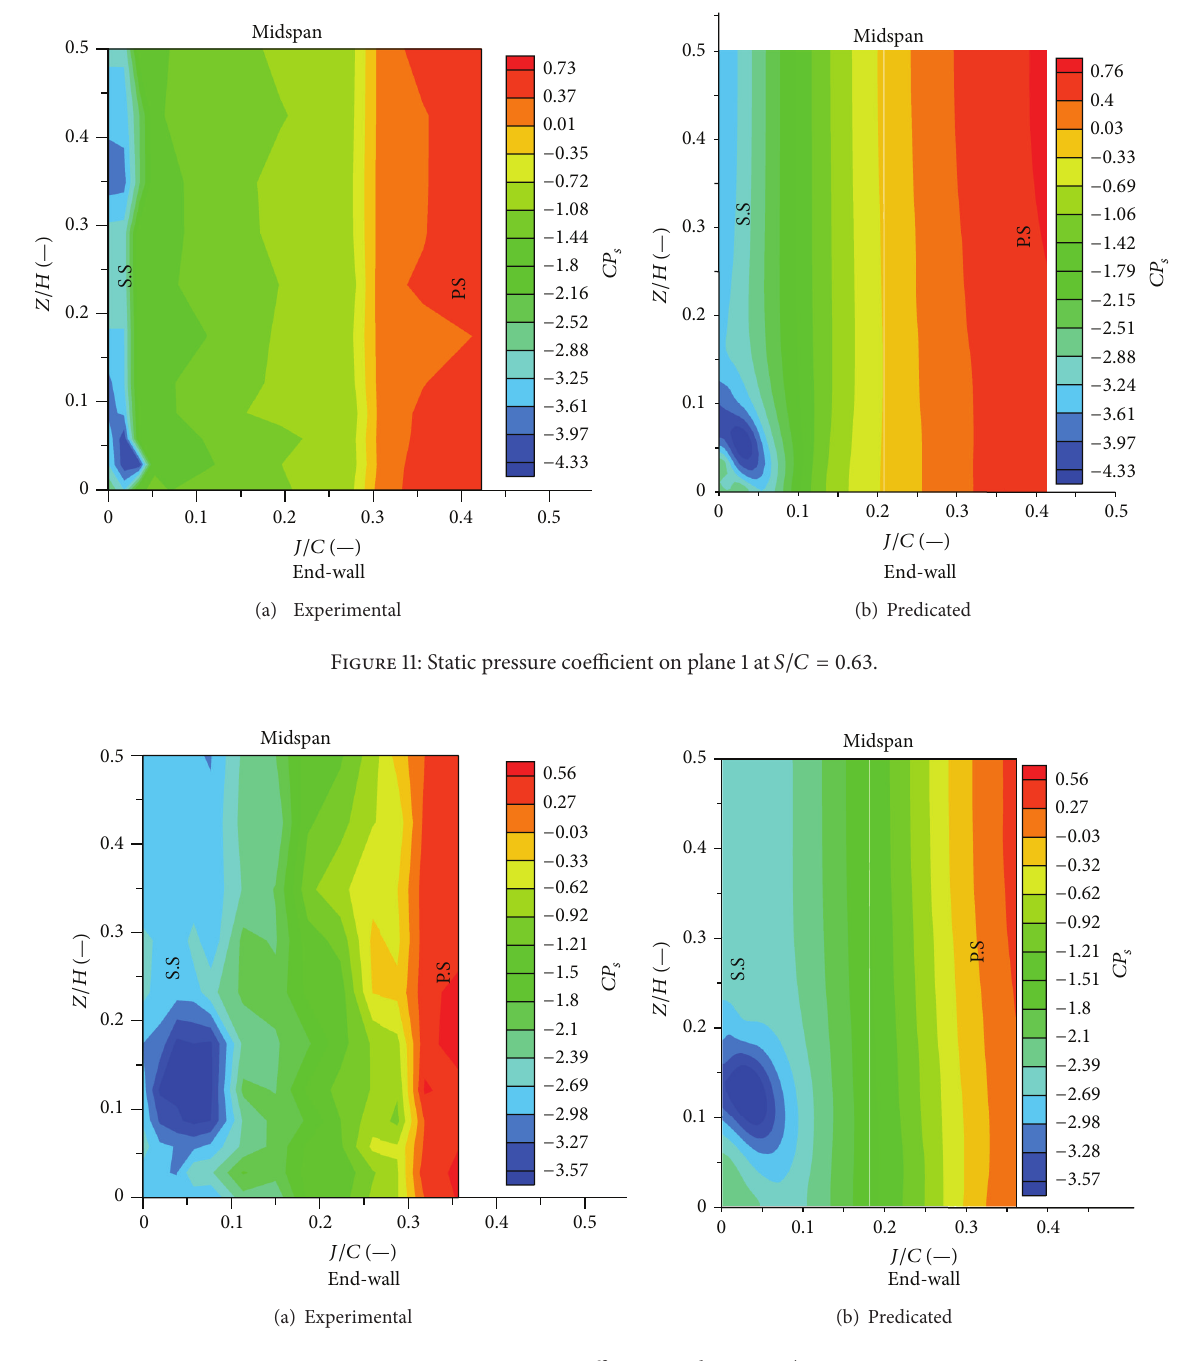
Figure 12: Static pressure coefficient on plane 2 at 𝑆/𝐶 = 0.89